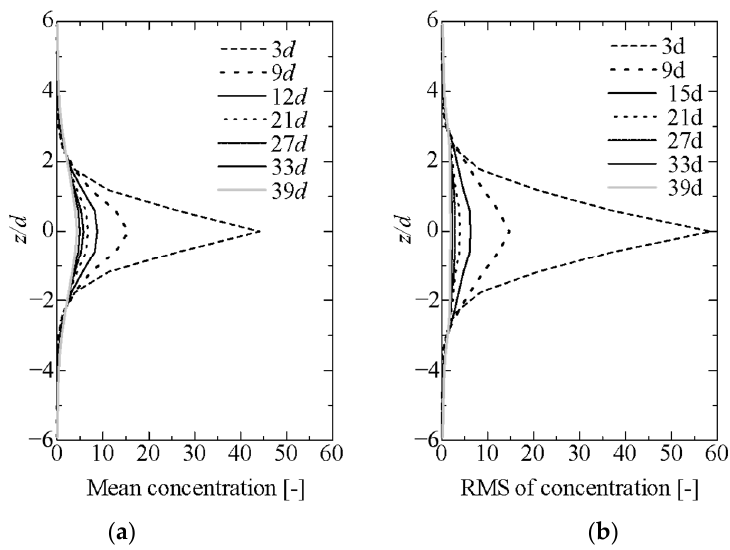
Figure 2. Concentration in the x direction at several points (3 d , 9 d , 15 d , 21 d , 27 d , 33 d , and 39 d from the source location): ( a ) mean profile of concentration at the plane y = 6 d ; ( b ) root-mean-square of the concentration at the plane y = 6 d .